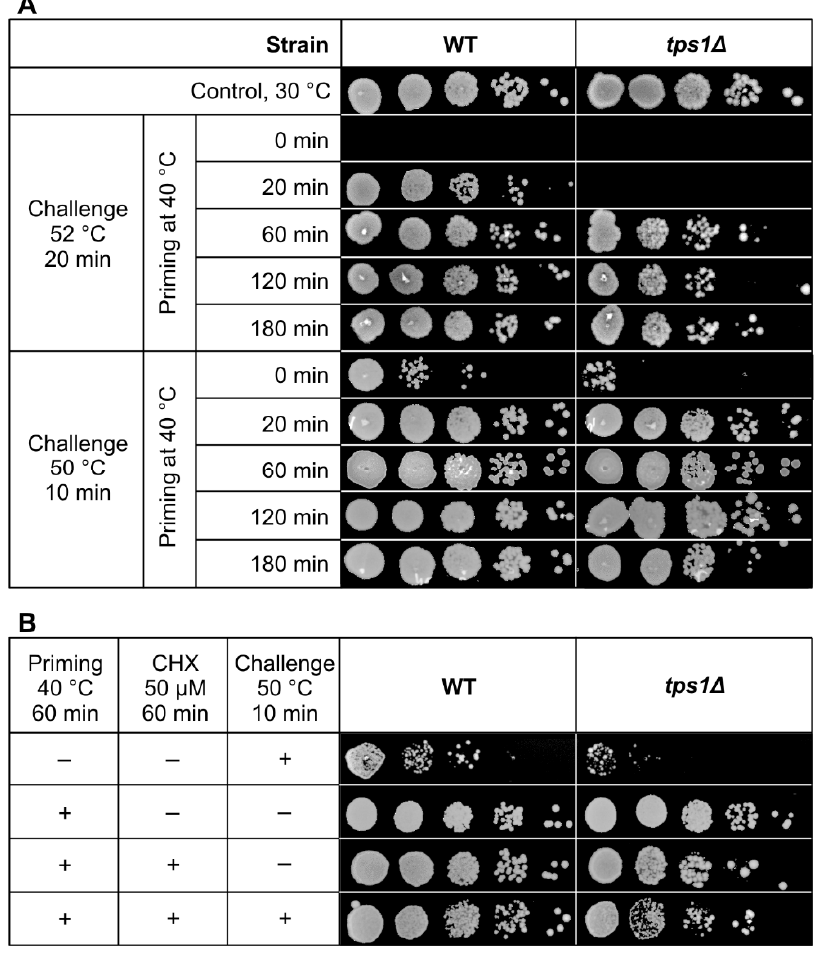
Figure 9. Acquisition of thermotolerance. ( A ) Yeast cells were primed at 40 °C for 0–180 min followed by heat challenge at 52 °C for 20 min or at 50 °C for 10 min. ( B ) Yeast cells were left untreated or primed at 40 °C for 60 min in the absence or presence of 50 μ M cycloheximide to inhibit translation followed by exposure to 50 °C for 10 min. Samples were then serially diluted (10×), spotted onto YES plates and incubated at 30 °C for four days. WT, wild-type; tps1 Δ , trehalose-deficient S. pombe strains; CHX, cycloheximide.